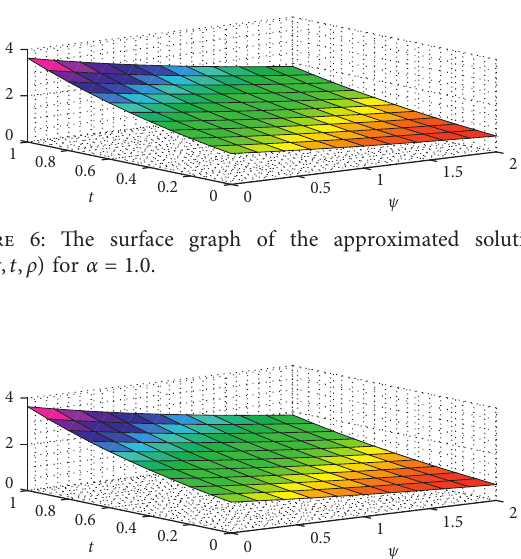
Figure 7: The behavior of the exact solution U ( ψ ,t, ρ )